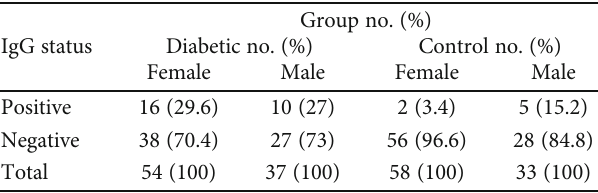
Table 6: Anti- Toxoplasma IgG and sex frequency among both